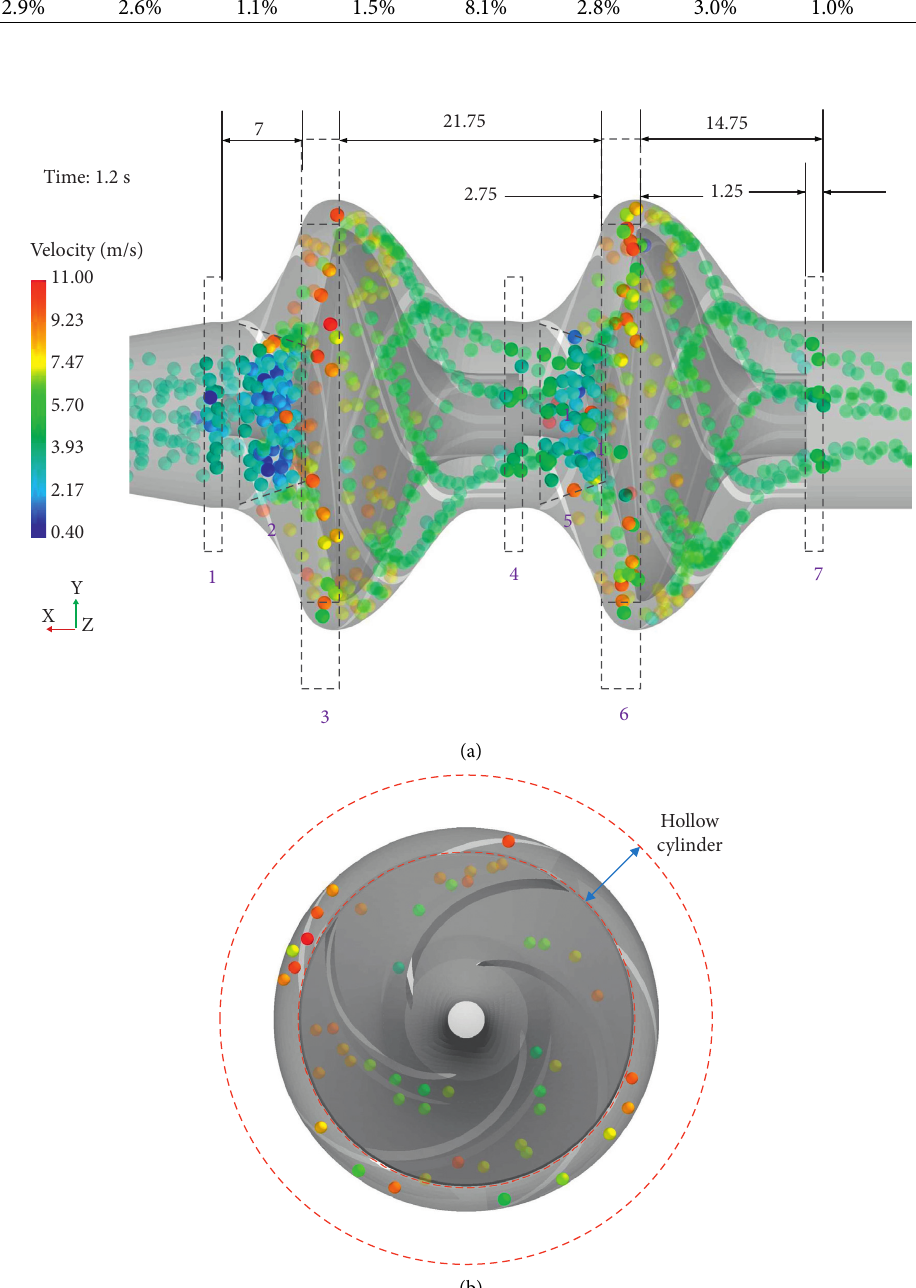
Figure 9: Distribution and velocity of particle groups at 1.2s with leakage. The velocity magnitude of the particles is marked as semi- transparent color spheres, among which seven important regions are emphasized as nontransparent spheres: (a) schematic diagram of partition of the pump and (b) front view of Region 3 or 6 shaped as a hollow